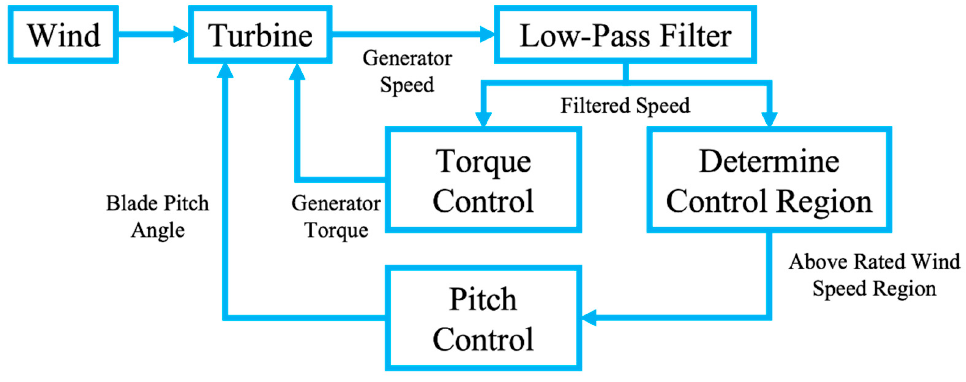
Figure 8. Schematic of employed control system.